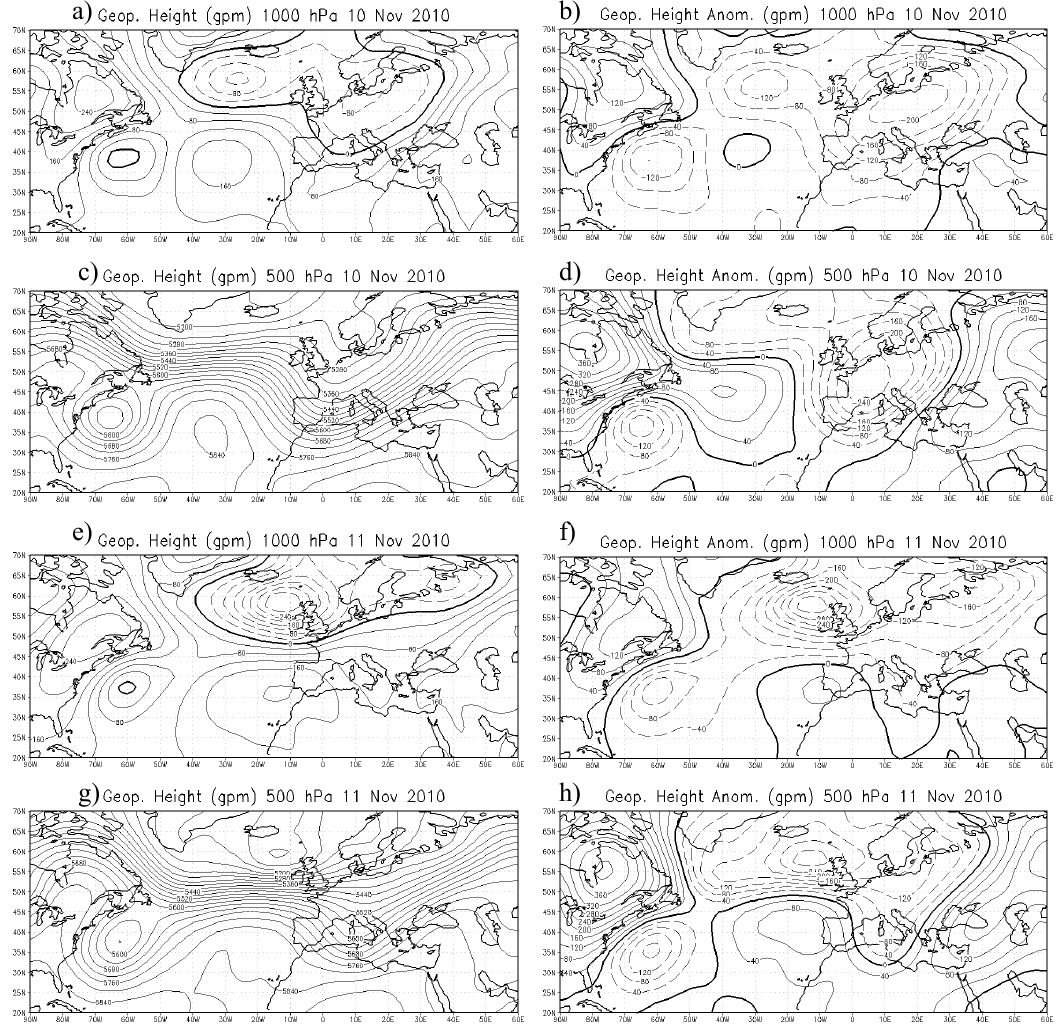
Figure 5 . Mean geopotential fields on 10 and 11 November 2010, and mean anomaly Fig. 5. Mean geopotential fields on 10 and 11 November 2010, and mean anomaly field (with respect to the long term 1958–2000 mean field field (with respect to the long term 1958-2000 mean field of the corresponding day) at of the corresponding day) at 1000hPa and 1000hPa and 500hPa